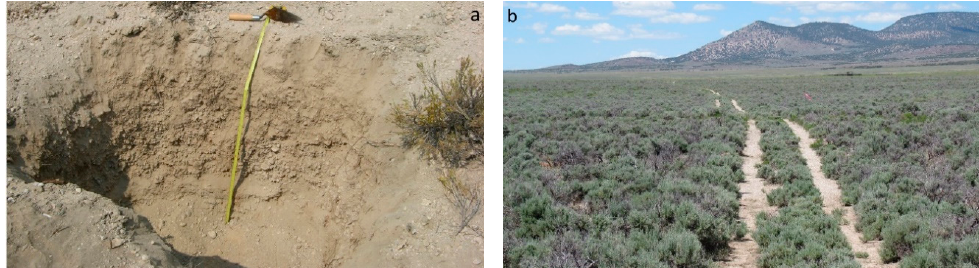
exposure. ( b ) View to the northwest along Transect A (Figure 2) showing the jeep trail crossing over multiple beach ridges. Pink flags, placed every 6 m, mark locations for the total station